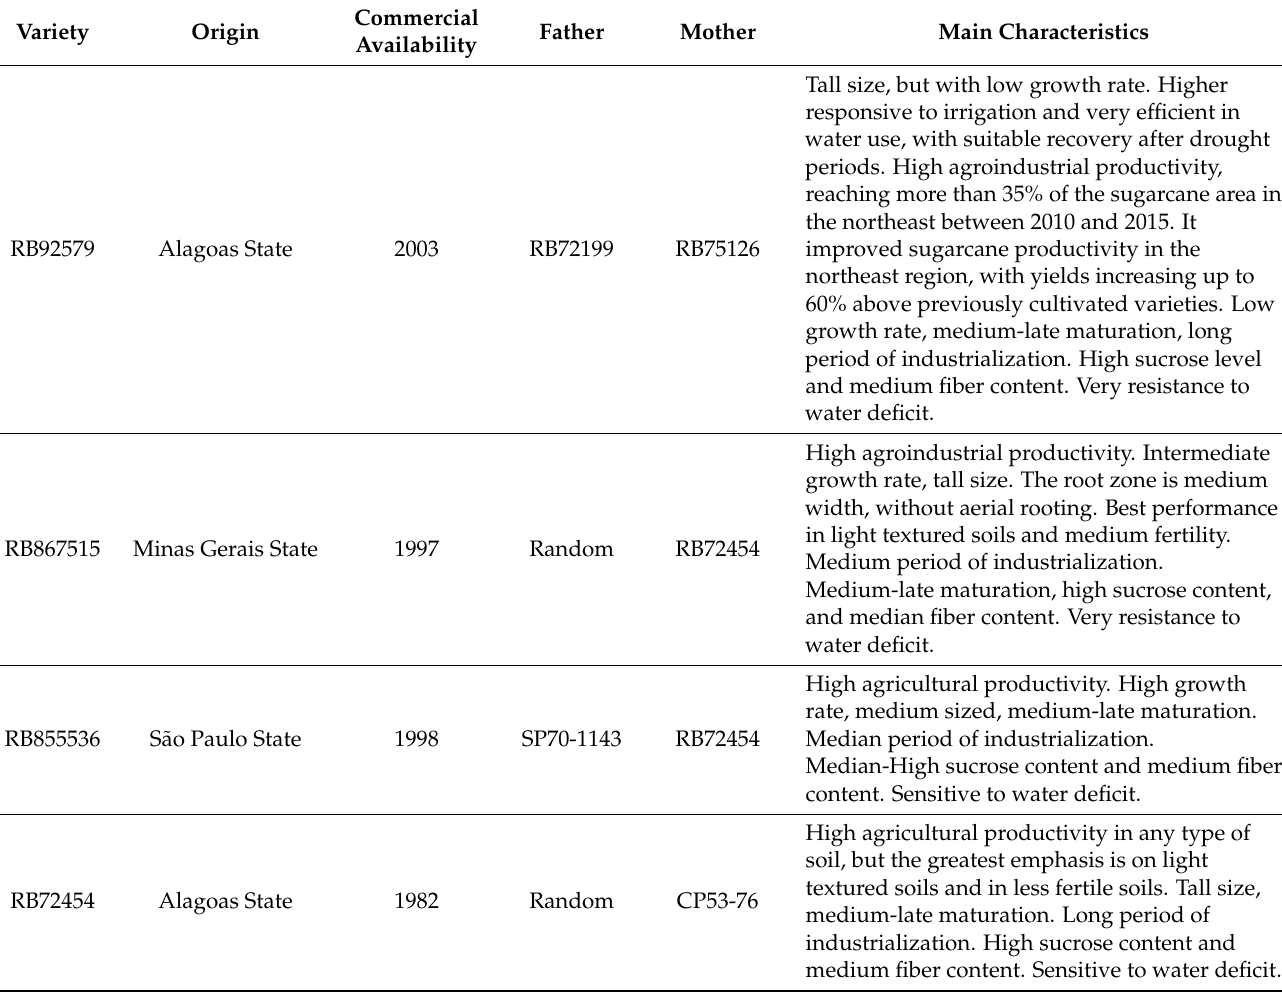
Table 1. Variety, origin, commercial availability, progenitors, and main characteristics of four